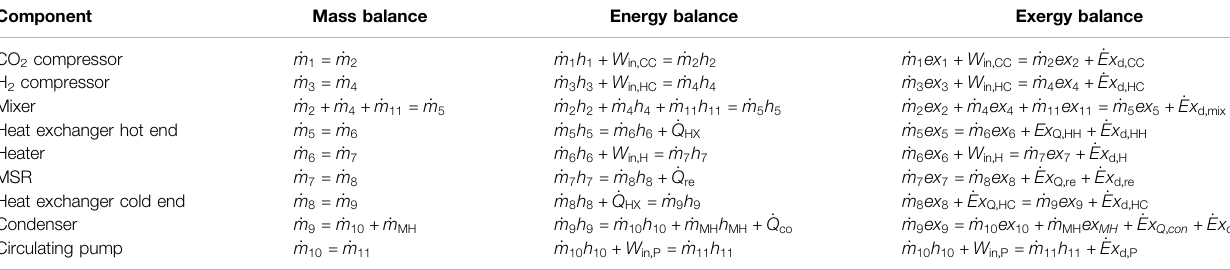
TABLE 2 | Speci fi cation and working parameters of the CDHM system.